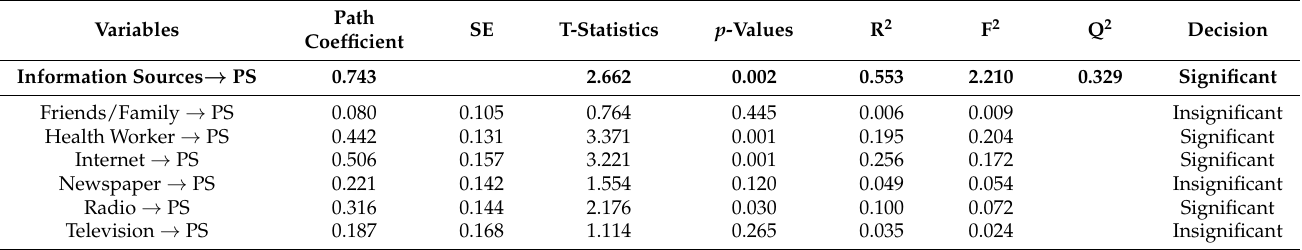
Table 9. Coefficient value of Hypothesis Two.